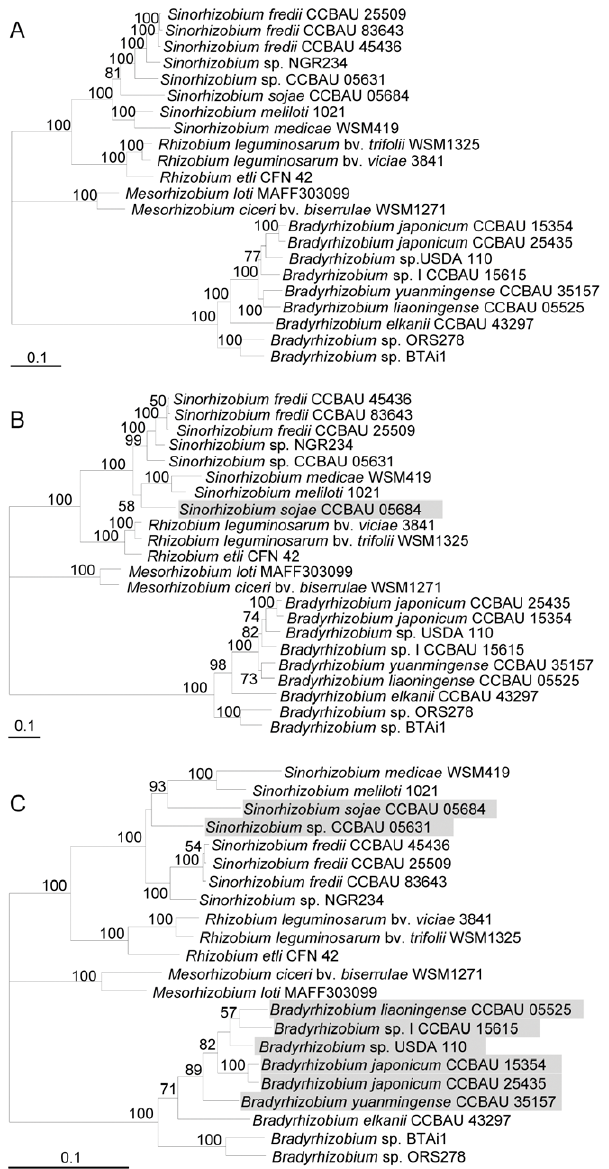
Figure 1. The maximum likelihood (ML) phylogenetic trees. The tree was constructed by PhyML based on concatenated sequences of 28 core genes (A), SMc00019-truA-thrA concatenate (B) or recA-glnII - atpD concatenate (C). Bootstrap confidence levels $ 50% are indicated at the internodes. Bar=10% nucleotide divergence. doi:10.1371/journal.pone.0044936.g001 28 interspecies ANIstt values were below 94% and S. kummerowiae should be a later synonym of S. meliloti due to the high ANIstt (99.51%) between their type strains. In Mesorhizobium (Table S9), 204/210 interspecies ANIstt values were below 94%, exceptions were found in M. tianshanense/M. tarimense (97.72%), M. temperatum/